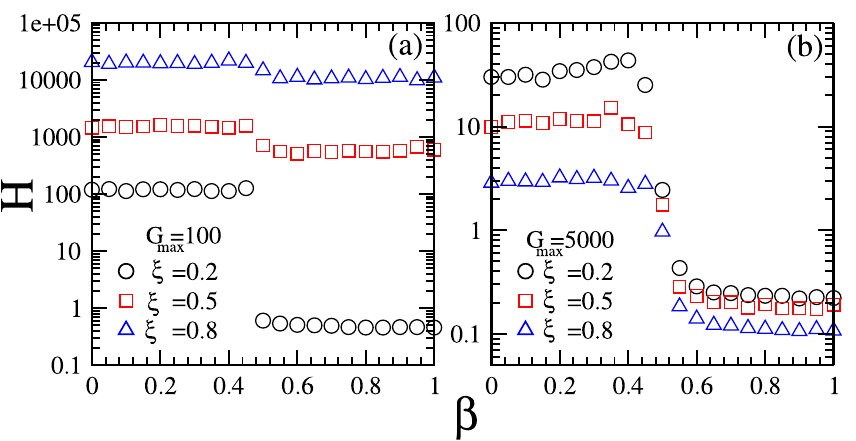
Fig 7. The predictability H of stock prices as a function of market impact β for different combinations of maximal of reference point strategies and the ratio ξ of individuals with reference point strategies. (a) risk tolerance G max G max = 100 and ξ = 0.2 (circles), 0.5 (squares), 0.8 (triangles); (b) G max = 5000 and ξ = 0.2 (circles), 0.5 (squares), 0.8 (triangles). Other parameters are: the population size N = 5001, the memory size m = 3 and m 0 = 10, the updating threshold of history-dependent strategies S = 0, the maximum drift of history-dependent strategies ε = 0.1, the th liquidity l ¼ N , the constant a ¼ 10 , minimum and maximum shares holding k = -1, k = 1. The initial conditions min max 10 N are: an individual’s risk tolerance G i is uniformly distributed within the range of G i 2 [0, G max ], an individual’s initial reference point p ref is uniformly distributed within the range of p ref 2 ½ � Pe (cid:0) a G i ; � Pe a G i � , initial history-dependent strategy i i g is distributed uniformly within the range of g 2 [0, 1], starting price P ( t = 0) is randomly chosen within the range of P 2 [0, 20], each individual’s initial number of shares k = 0, each individual’s initial wealth W ( t = 0) = 0, each i individual’s initial cash C i ( t = 0) =